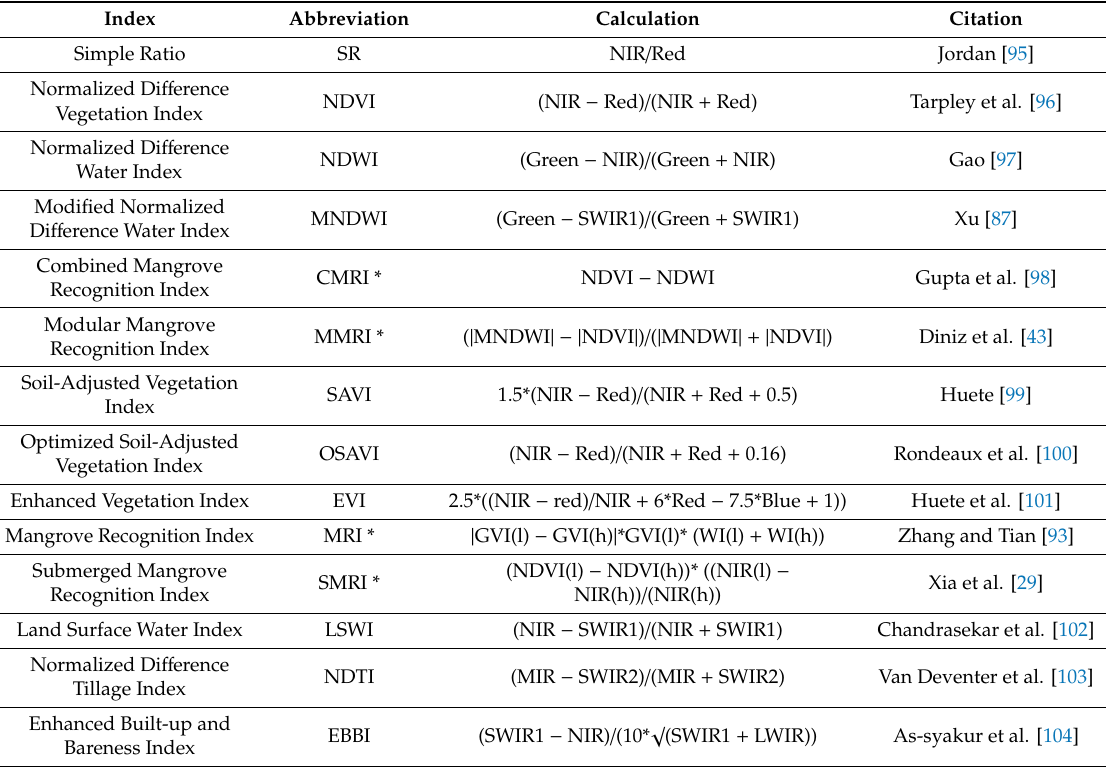
Table 3. List of all spectral indices available in the GEEMMM including mangrove-specific.